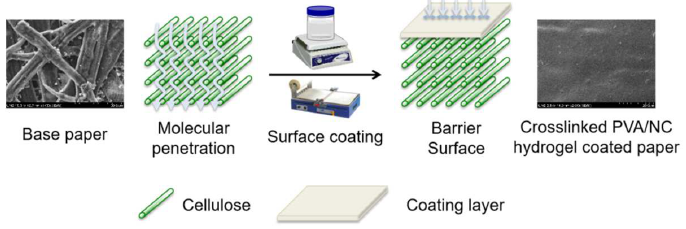
Figure 1. Scheme of coating application on paper surface with a Mayer bar.